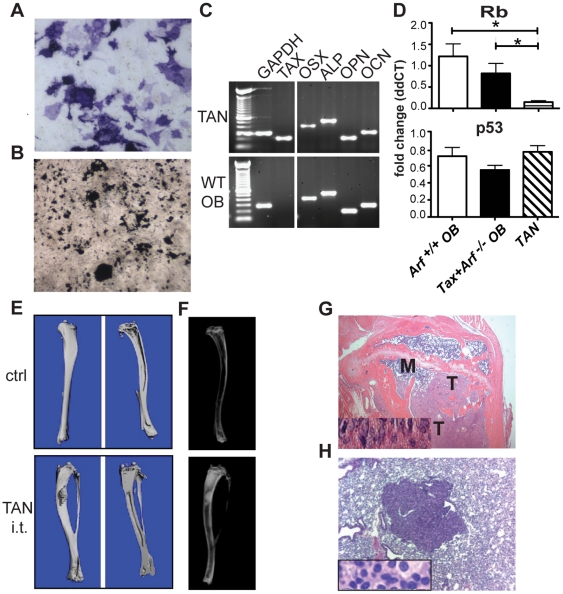
Orthotopic inoculation of a Tax+Arf-/- osteosarcoma cell line induced mineralized tumors.a) Alkaline phosphatase (ALP, purple) staining of Tax+Arf-null (TAN) OS line. b) von Kossa staining (black) showing mineralization of TAN cells after 10 days of culture under osteogenic conditions. c) TAN cells express mature OB markers by RT-PCR. OSX = osterix, ALP = alkaline phosphatase, OPN = osteopontin, OCN = osteocalcin. d) Quantitative RT-PCR for Rb (top) and p53 (bottom) expression in d20 in vitro differentiated OB from Arf
+/+ (open bars), Tax+Arf-/- (closed bars), or TAN OS cells (hatched bars). Data is represented as fold change following normalization to cyclophilin levels. Significance values of Rb: Arf
+/+ OB vs TAN p = 0.0109; Tax+Arf-/- OB vs TAN p = 0.0287. e–g) TAN cells form tumors when transplanted intratibially into immunocompromised NSG mice. e) 3D reconstruction from microCT analysis of contralateral control tibia (top) and TAN-injected tibia (bottom). Arrowheads note area of abnormal mineralization. f) Radiographs of tibias as in (e). g) H&E. M = marrow, T = tumor. Inset shows high power magnification demonstrating pathological osteoid deposition (light pink). h) TAN cells metastasize to lung following intravenous transplant. H&E staining of a metastatic lung lesion, inset shows high power magnification.